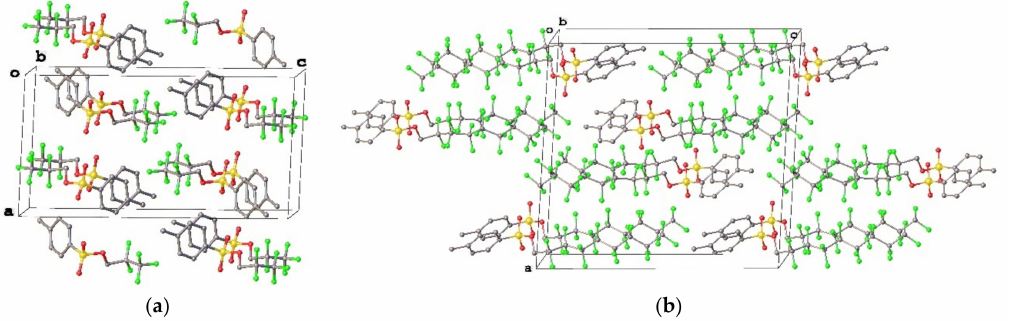
Figure 7. Crystal packing of 1 ( a ) and 4 ( b